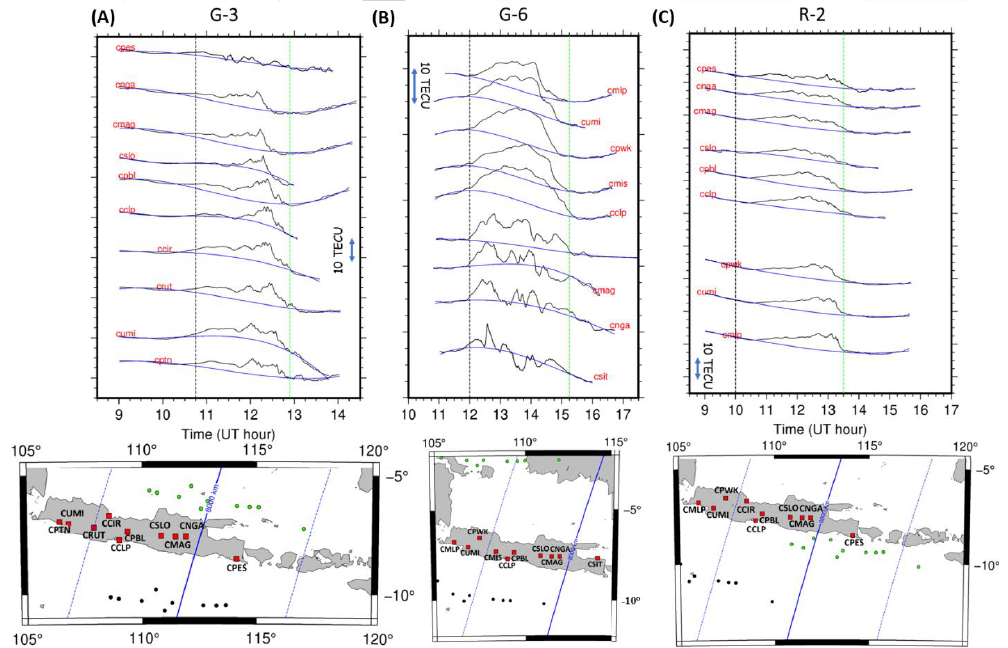
Figure A1. Time series of VTEC data showing diversity in the waveforms (black curves) of disturb- ances due to LW propagating from the HTHH volcano following its eruption on Jan. 15, observed using G3 ( A ), G6 ( B ) and R2 ( C ) at stations in Indonesia. They are plotted in sequence (top to bottom) following station position (red squares) from east to west. SIP positions are shown in black and green dots on maps at the times marked by black and green dashed lines on the GNSS-TEC time series. Blue curves are low-degree best-fit polynomials of the VTEC data with the exclusion window (data within this window are not used to estimate the polynomials) between dashed